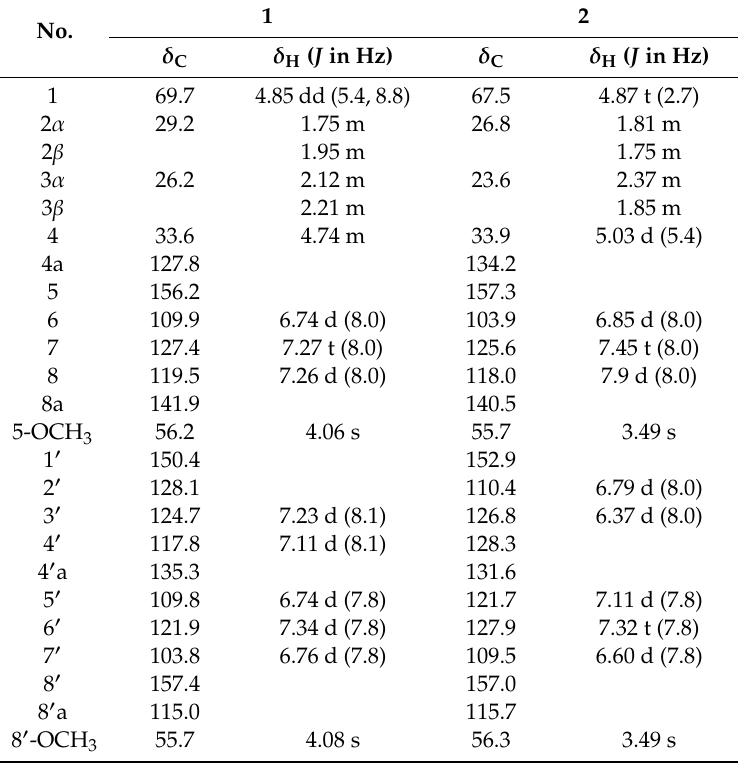
Table 1. 1 H (500 MHz) and 13 C-NMR (125 MHz) Data of Compounds 1 – 2 (in CDCl 3 ).